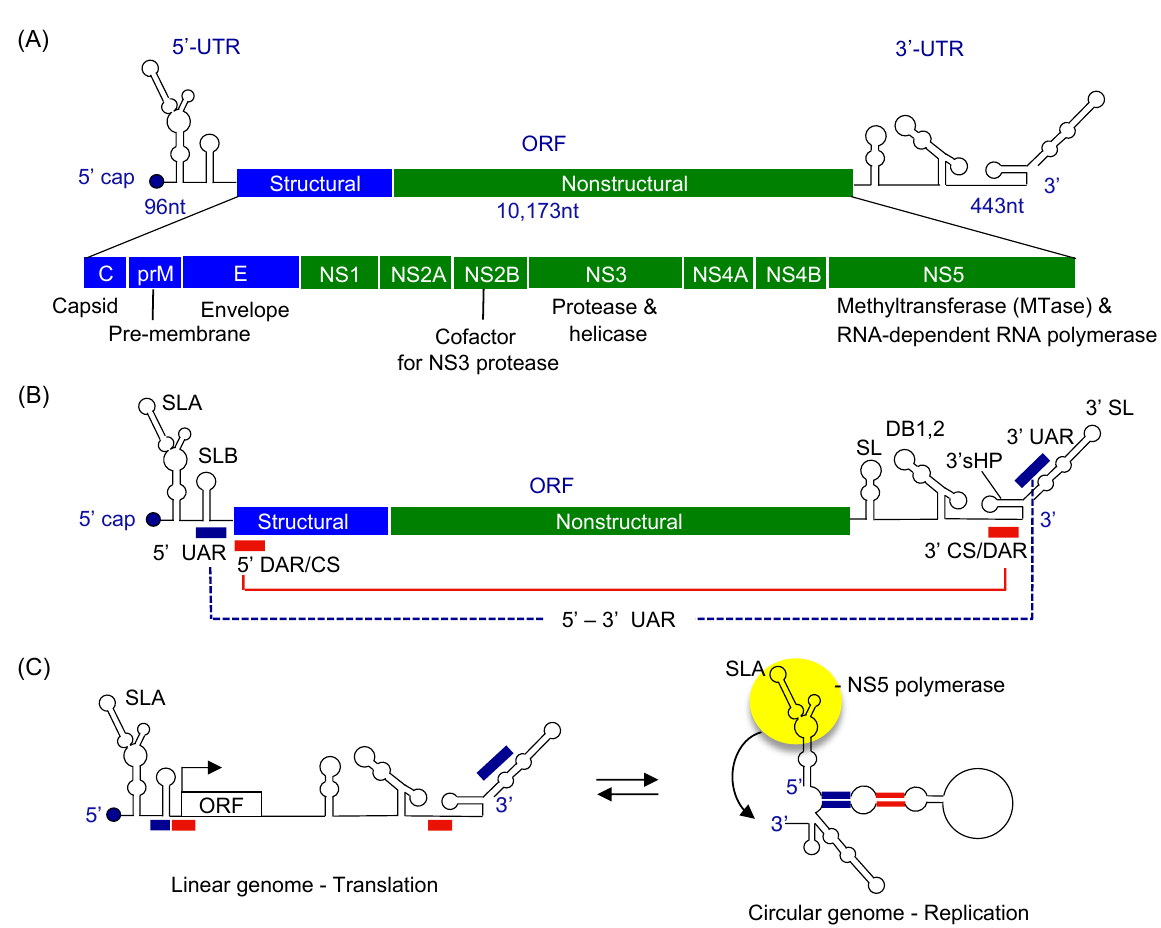
Figure 1. Flavivirus genome organization. ( A ) Genome organization of flaviviruses. The viral genome contains a single open-reading frame (ORF) and is translated into a single polyprotein consisting of structural (C, prM, and E), and the non-structural proteins (NS1, NS2A/B, NS3, NS4A/B, and NS5). The known functions of the viral proteins are listed below. The viral genome is flanked by 5 (cid:48) and 3 (cid:48) untranslated regions (UTRs) containing RNA structures important for viral replication. The 5 (cid:48) terminus of the genome is modified with a type 1 cap structure. ( B ) Flavivirus RNA regions required